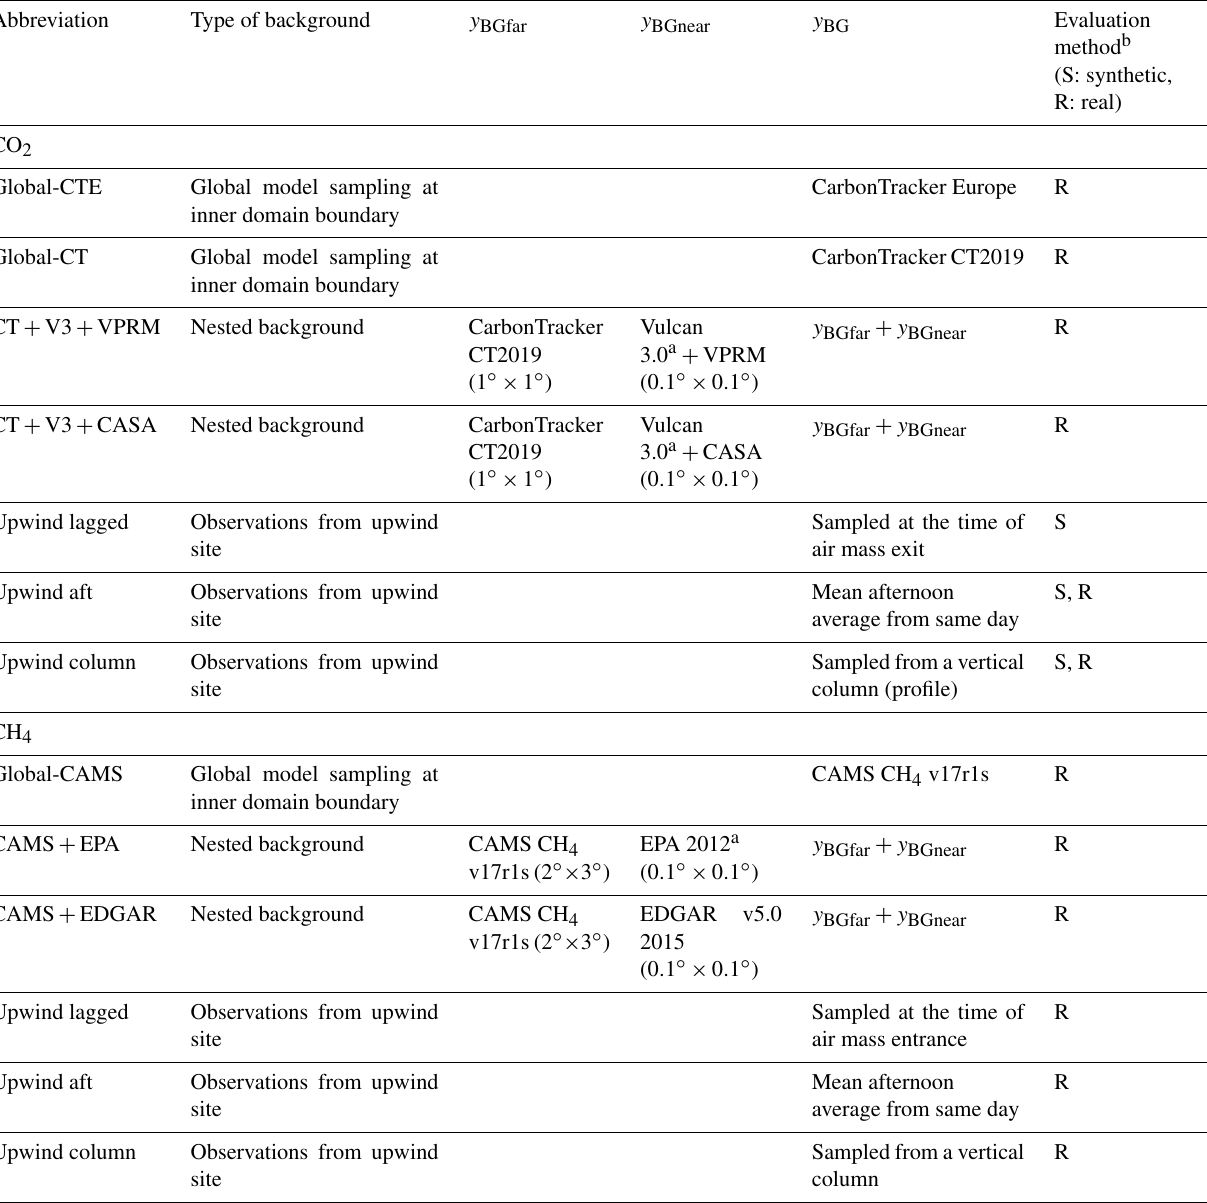
Table 1. Summary of background methods compared and evaluated for CO 2 and CH 4 . References for all the models can be found in the pertinent Methods